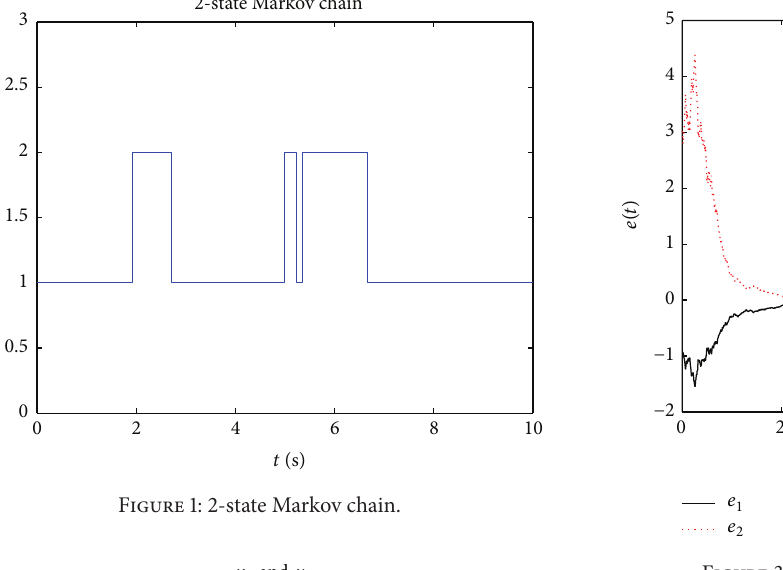
Figure 3: State trajectory of the error system.